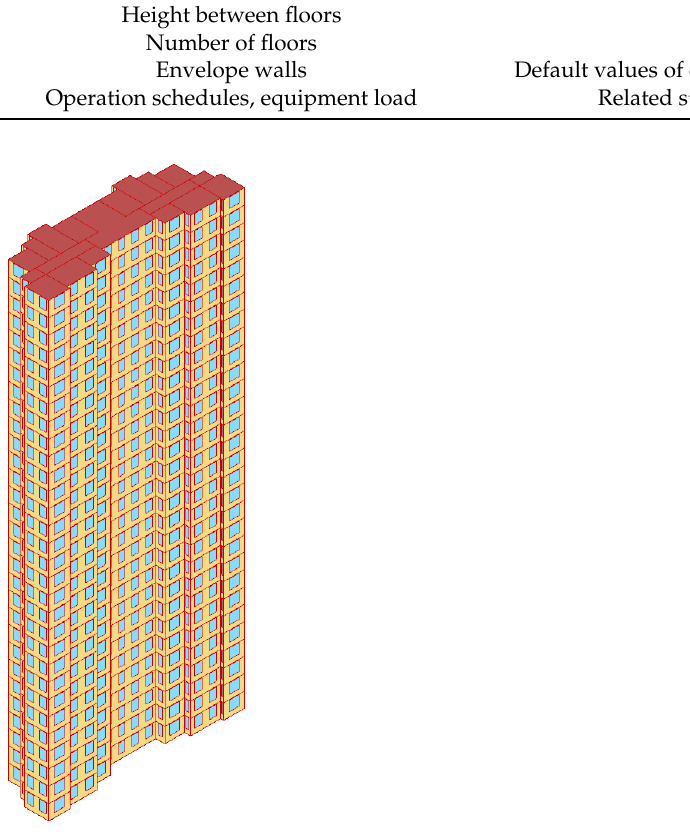
Table 2. The value of the attributes used in the optimization process.